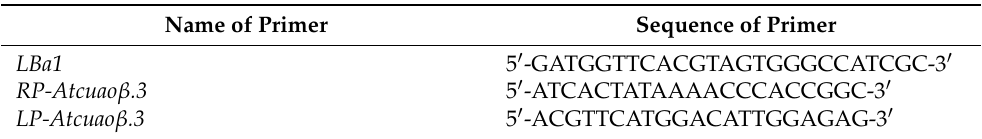
Table 1. Primers used for identification of the T-DNA insertional loss-of-function Atcuao β .3 mutants by PCR